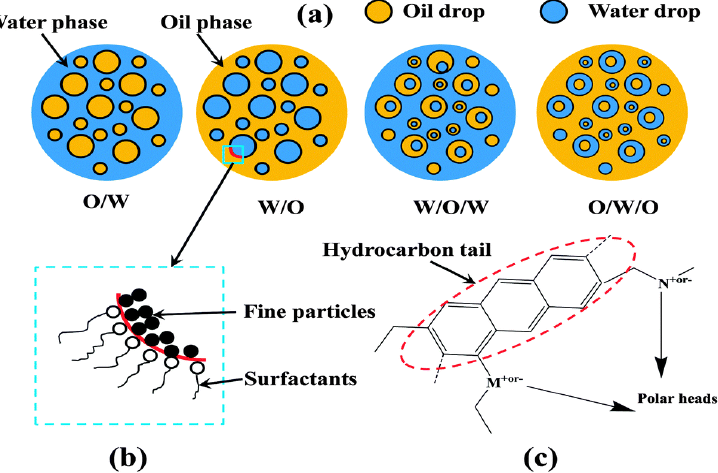
Figure 1. Schematic of common types of emulsions and their compositions. ( a ) Emulsions generated in crude oil production and transportation ( b ) Formation of rigid films at the oil–water interface and ( c ) surface activity of asphaltene molecules. Reproduced with permission from He et al., 2015 (ref. [27]). Copyright The Royal Society of Chemistry 2015.